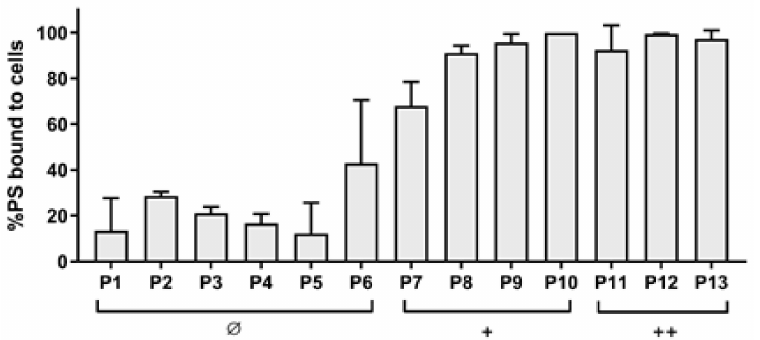
Figure 2. Binding assay of diaryl-porphyrins ( P1 – P13 ) to S. aureus ATCC 6538P. Values are presented as a percentage of PS bound to cells upon 1 h of dark incubation. The neutral (Ø), monocationic (+), and dicationic (++) porphyrins were administered at a concentration of 10 µ M. The experiments were performed in triplicate and standard deviation is reported.